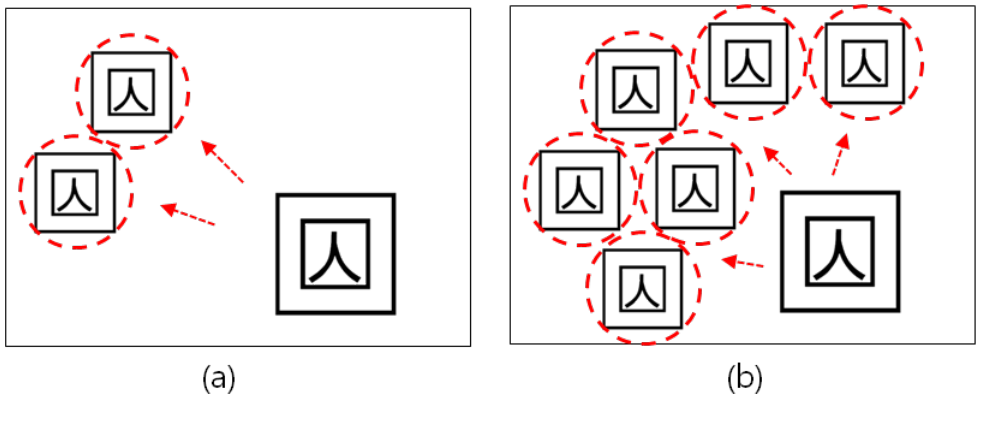
Figure 10. Overlapping control during marker creation, by designating the created areas as non-overlapping